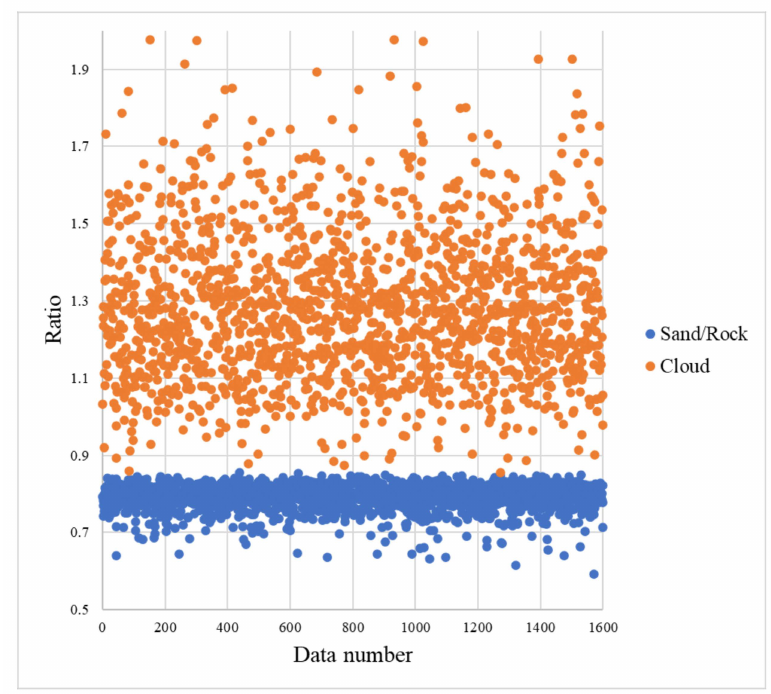
Figure 3. Distribution in the ratios of Band 2 to Band 6 of clouds and sand. See text for